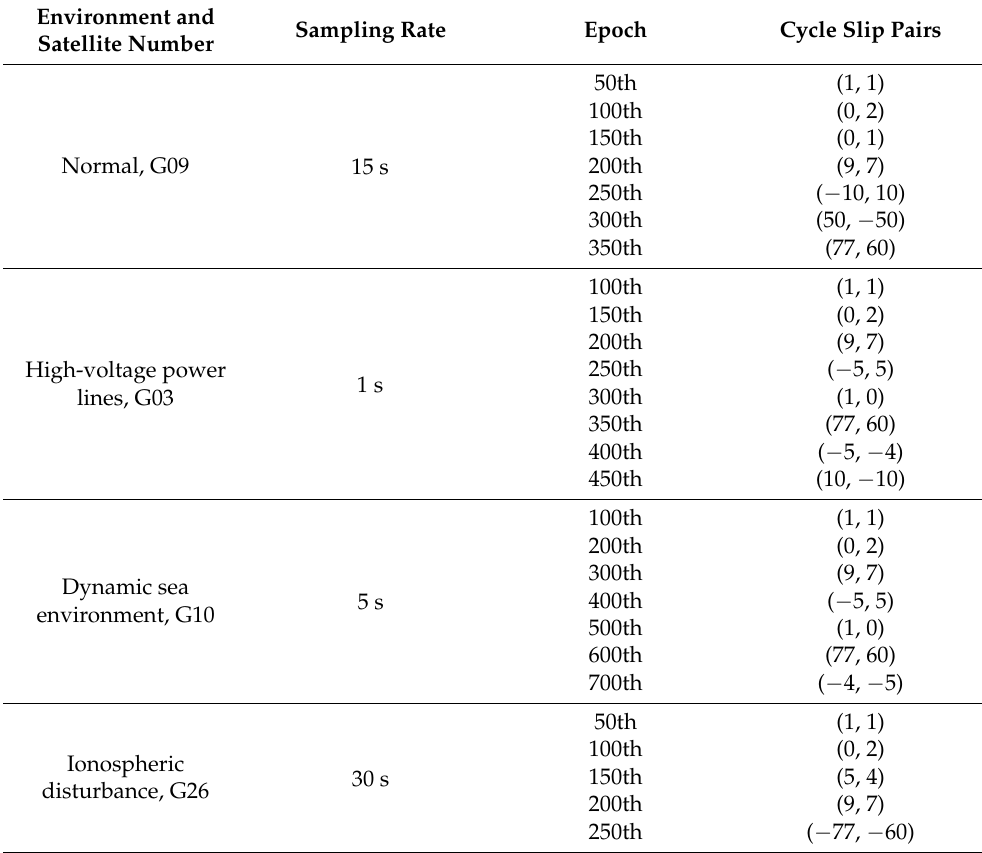
Table 1. Cycle slip pairs in carrier phase data of each low elevation